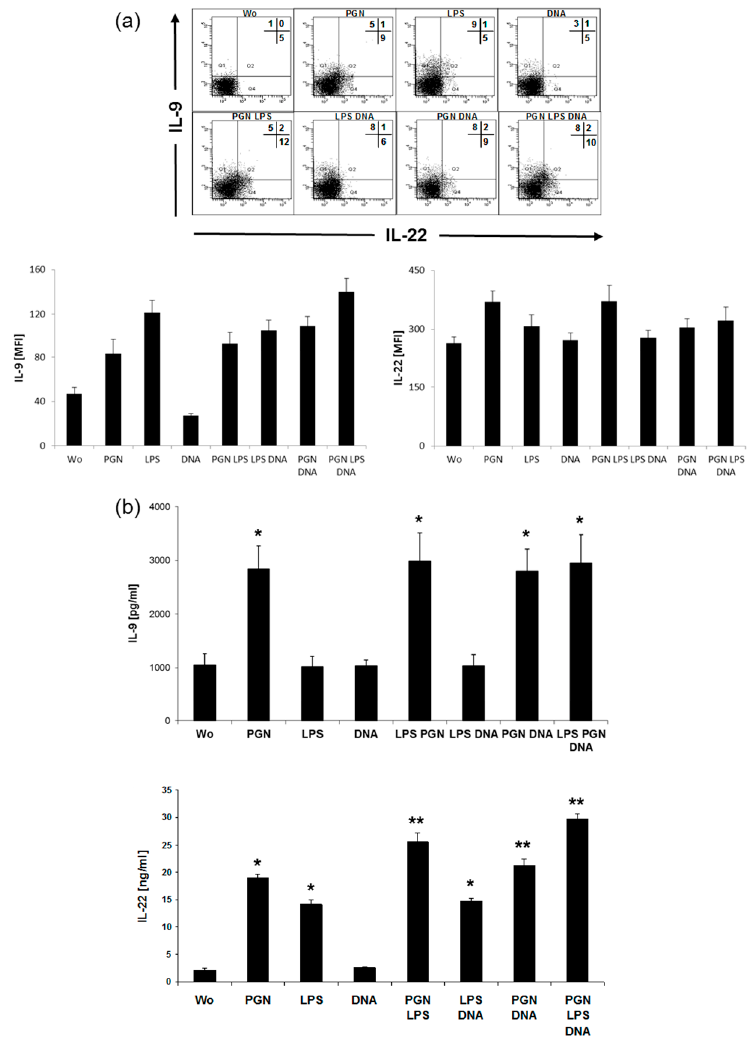
Figure 6. LPS, PGN and DNA synergize in inducing IL-22 and IL-9. After 48 h stimulation with 20 µ g/mL PGN, 1 µ g/mL LPS and 5 µ g/mL DNA, stimuli were removed by washing and LCs further cocultured with allogeneic CD4 + T cells. ( a ) Coexpression of IL-22 with IL-9 in cells cultured for 5 days. Shown is one experiment representing a total of tree with different donors, numbers indicate the percentage of positive cells, means of fluorescence intensity (mean FI) were analyzed from the dotplots. Bars indicate mean fluorescence intensity (MFI) ± SD from intracellular FACS for IL-9 and IL-22. ( b ) After additional 5 days, supernatants were analyzed for IL-9 and IL-22 by ELISA. Bars represent amounts of protein as inter-experimental means ± SD of cytokine secretion in the supernatants of T cells from experiments using 5 independent MoLC and T cell donors. Differences of values for cytokines after stimulation were analyzed for statistical significance and compared to control (without, wo); * p ≤ 0.05, ** p ≤ 0.01.